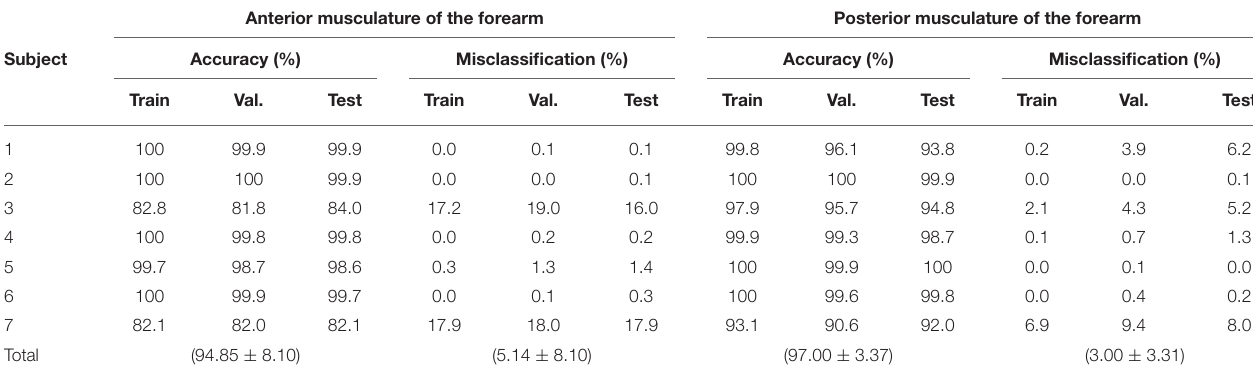
TABLE 4 | Accuracy of the supervised classification methods for the flexor and extensor muscles by stages of neural network: training, validation and testing. Anterior musculature of the forearm Posterior musculature of the